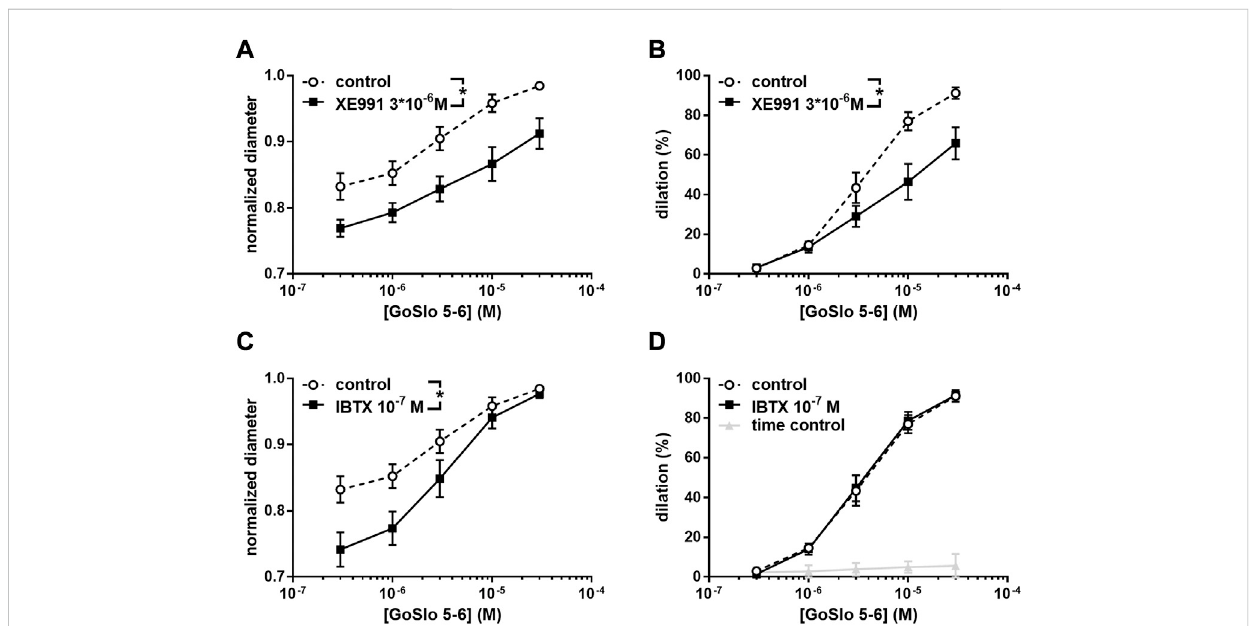
FIGURE 3 Effect of GoSlo-SR 5-6 on spontaneous tone of isobaric vessel preparations of rat Gracilis muscle arteries at 80 mmHg. (A) Normalised vessel diameter (ratio of diameter/fully relaxed diameter at 80 mmHg) at different concentrations of GoSlo-SR 5-6 in the absence (control) and presence of 3*10 – 6 MXE991( n =10; p < 0.05); (B) vesseldilationatdifferentconcentrationsofGoSlo-SR5-6intheabsence(control)andpresenceof3*10 – 6 MXE991 ( n = 10; p < 0.05); (C) Normalised vessel diameter at different concentrations of GoSlo-SR 5-6 in the absence (control) and presence of 10 – 7 M IBTX ( n = 7; p < 0.05); (D) vessel dilation in the absence (time control = application of GoSlo-SR 5-6 solvent DMSO) and presence of GoSlo-SR 5 – 6 (control) ( n = 7; p < 0.05), vessel dilation at different concentrations of GoSlo-SR 5-6 in the absence (control) and presence of 10 – 7 M IBTX ( n = 7; p = 0.94). Reproduced and modi fi ed with permission from (Zavaritskaya et al.,